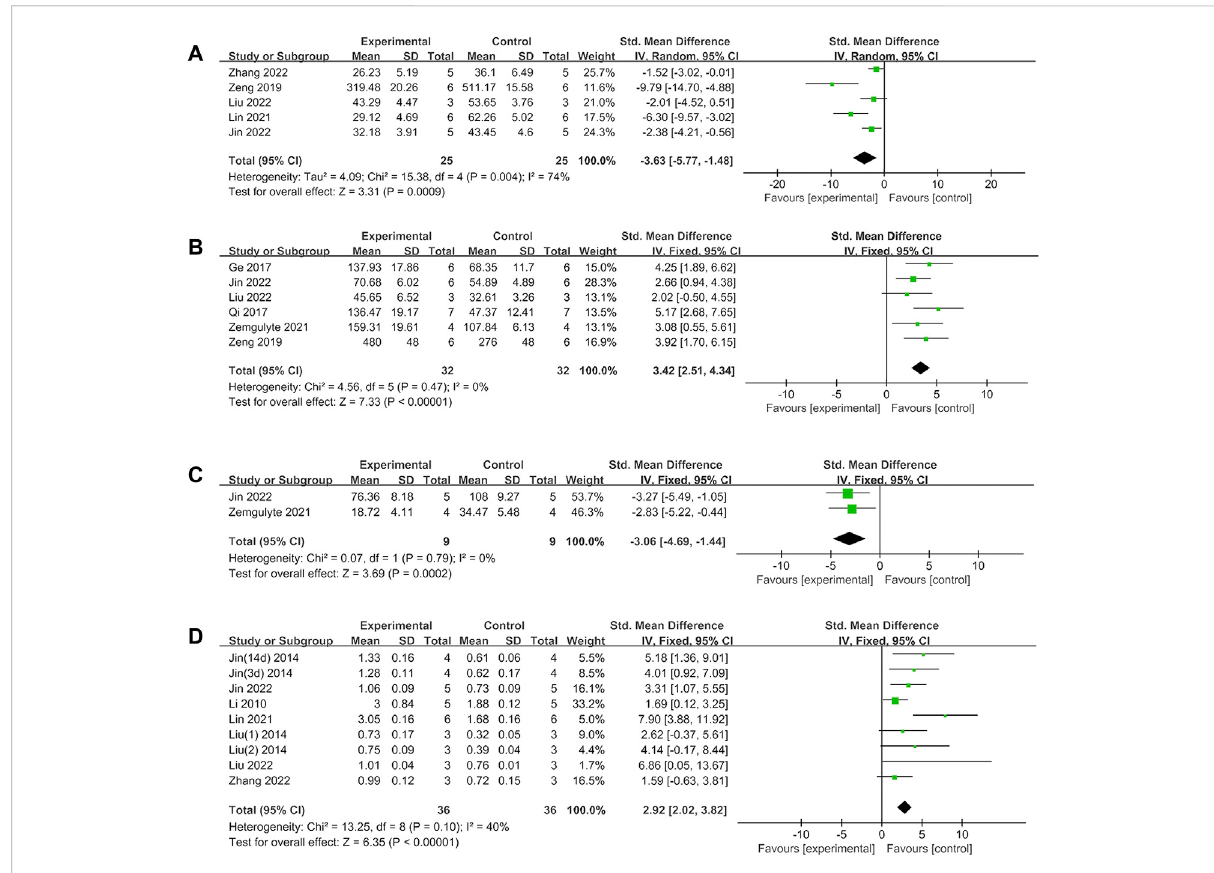
FIGURE 3 (A) Forest plot analyzing the effect of metformin treatment of TUNEL. (B) Forest plot analyzing the effect of metformin treatment of the neuron quantity. (C) Forest plot analyzing the effect of metformin treatment of the microglia quantity. (D) Forest plot analyzing the effect of metformin treatment of